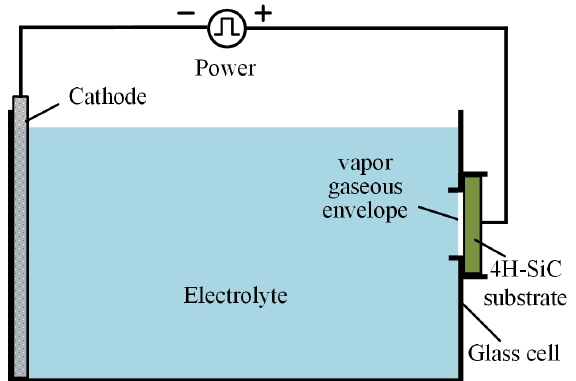
Figure 2. Schematic of plasma electrolytic processing setup.